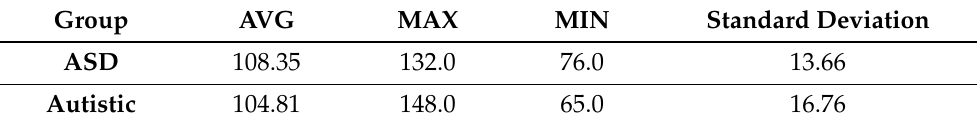
Table 7. FIQ distribution.